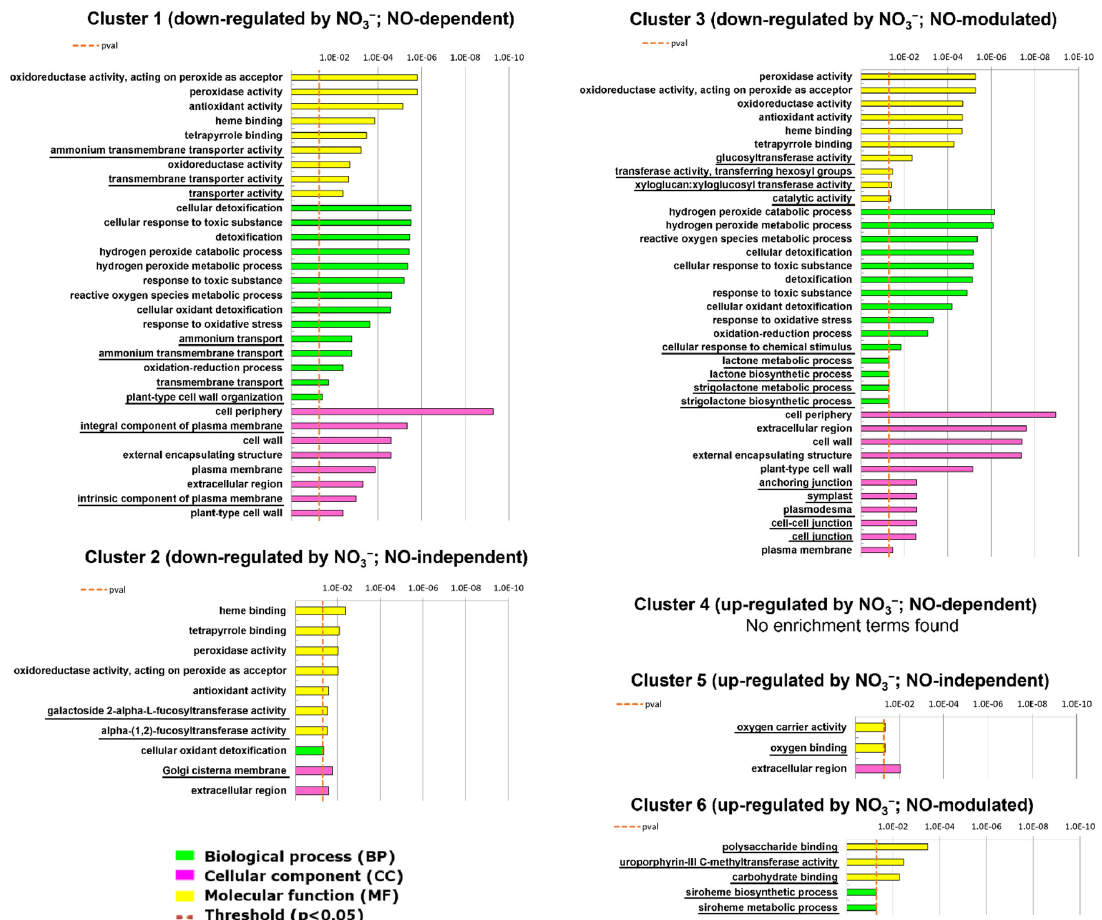
Figure 2. Enrichment analysis of DEGs clustered in 6 groups using gProfiler. The figure shows the GO categories overrepresented among genes down-regulated by nitrate provision and NO-dependent (cluster 1), down-regulated by nitrate and NO-independent (cluster 2), down-regulated by nitrate and NO-modulated (cluster 3), up-regulated by nitrate provision and NO-independent (cluster 5), or up-regulated by nitrate and NO-modulated (cluster 6). The specific and unique terms for each group are underlined. No enriched terms were found among DEGs up-regulated by nitrate provision and NO-dependent (cluster 4).